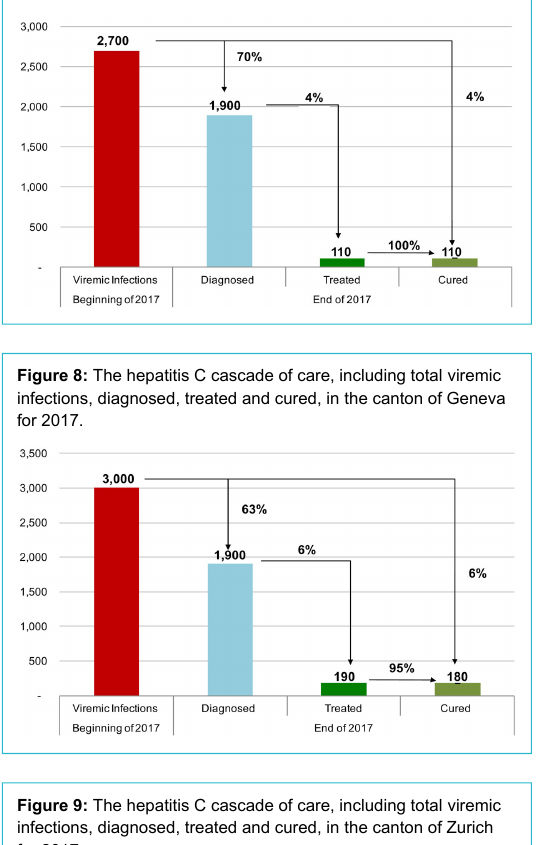
Figure 11: Distribution of viremic infections by disease stage in the canton of Geneva from 1950–2030 under the Base 2016 scenario.